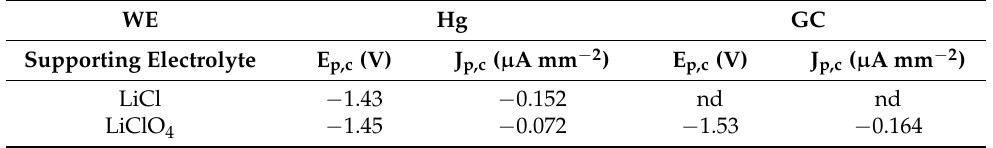
Table 4. Cathodic peak potentials E p,c (V vs. SCE) and cathodic peak current densities J p,c ( µ A mm − 2 ) in the SWV determination of HMF (concentration: 16 µ mol dm − 3 ) by varying the nature of WE (Hg or GC) and that of the supporting electrolyte (LiCl or LiClO 4 , both 0.1 mol dm − 3 in water). Potential scan rate: 0.10 V s − 1 ; cathodic window of potential: between 0 and − 2.00 V vs. SCE; AE: Pt; RE: SCE; pulse height: 4 mV; frequency: 15 Hz; modulation amplitude: 25